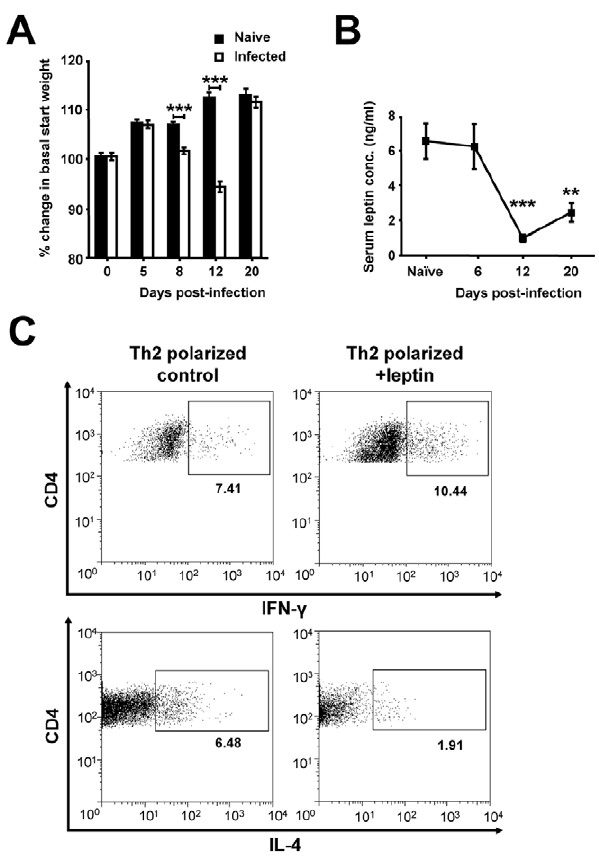
Figure 4. Hypophagia and weight loss during T.spiralis induced enteritis reduces the pro-inflammatory adipokine leptin. ( A ) Change in basal weight during infection. ( B ) Serum leptin levels during infection, determined via ELISA. ( C ) Representative CD4 + intracellular IFN-y and IL-4 flow cytometry plots during Th2 polarization in control and leptin treated mLN cells. Data (n=4–8 mice per group) are from two independent experiments. *, P , 0.05; **, P , 0.01; or ***, P , 0.005 between naı¨ve and infected groups or for indicated comparisons, error bars represent SE of means.